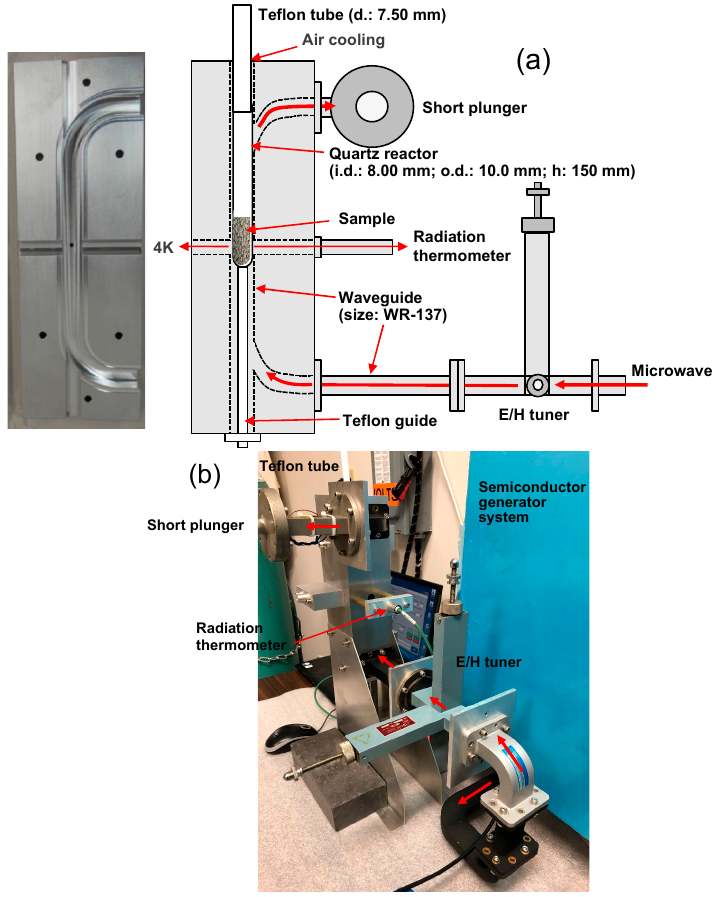
Figure 9. ( a ) Schematic illustrating the details of the experimental setup in the variable frequency microwave (VFM) chemical reaction equipment and the quartz reactor within the cavity (inset photo on the left shows the cross-section image of the single-mode applicator); ( b ) actual photograph of the VFM chemical reaction equipment.